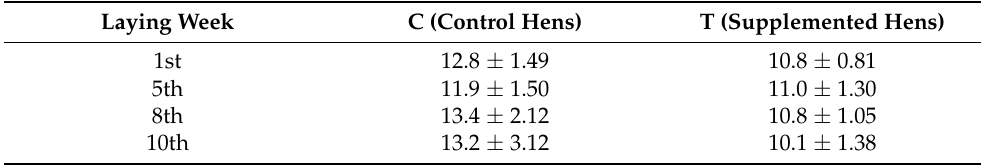
Table 3. Cholesterol content in yolk. Data are reported as mean ± SD (n = 3) and expressed as mg g − 1